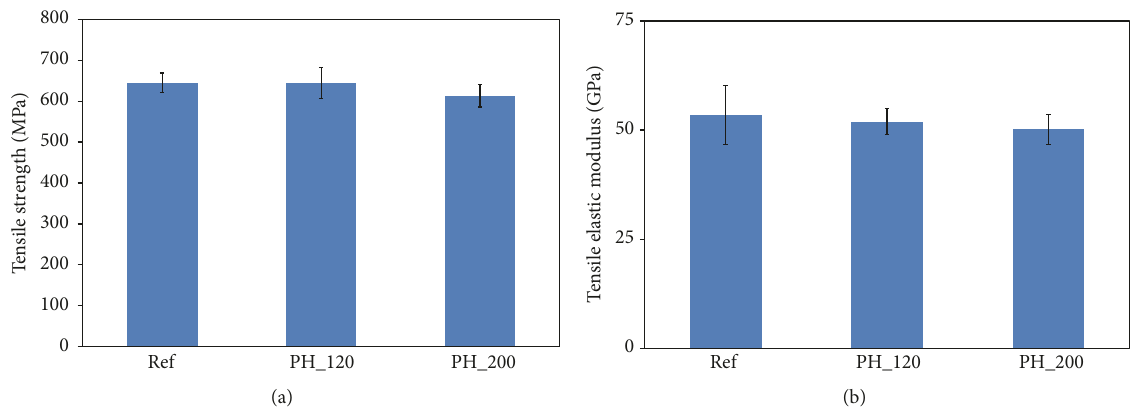
Figure 8: Test results for Ref and PH specimens that were not immersed in alkali solution: (a) tensile strength and (b) elastic